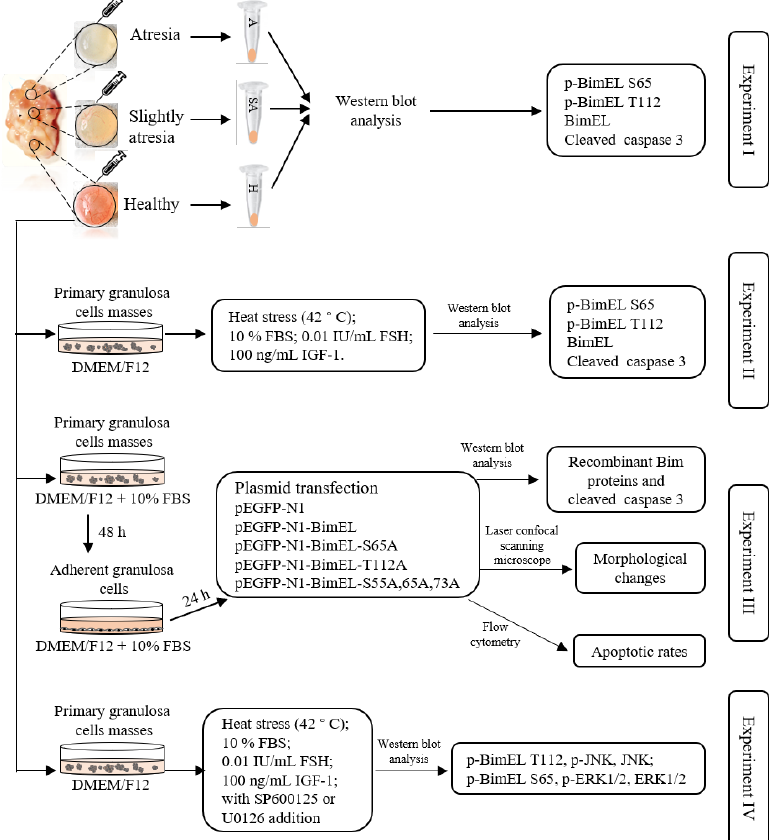
Figure 1. The workflow schematic of this study. Experiment I: Both levels of p-BimEL S65 and p-BimEL T112 in the granulosa cells from healthy, slightly-atretic, and atretic follicles were compared. Experiment II: The effects of proapoptotic factor (heat stress) and prosurvival factors (serum, FSH, and IGF-1) were observed on the levels of p-BimEL S65 and p-BimEL T112. Experiment III: The effects of phosphorylation at Ser65 and Thr112 were observed during apoptosis in porcine granulosa cells. Experiment IV: The potential pathways were suggested to induce the levels of p-BimEL S65 and p-BimEL T112 by the prosurvival or proapoptotic factors. Primary granulosa cells masses = granulosa cells recovered from follicles; adherent granulosa cells = monolayer adherent granulosa cells after in vitro culture.